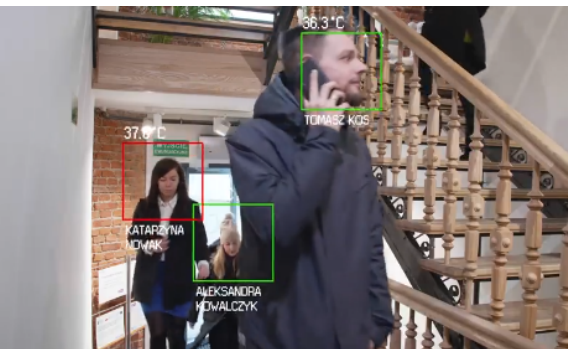
Figure 3. Sample image from the video datalog of the system, visualizing the data acquired by the thermal imaging sensor